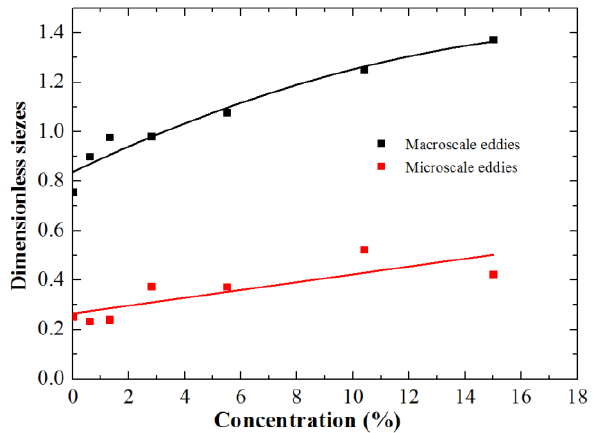
Figure 14. Relationships between eddy sizes and particle concentrations taken by Wang and Qian [37].